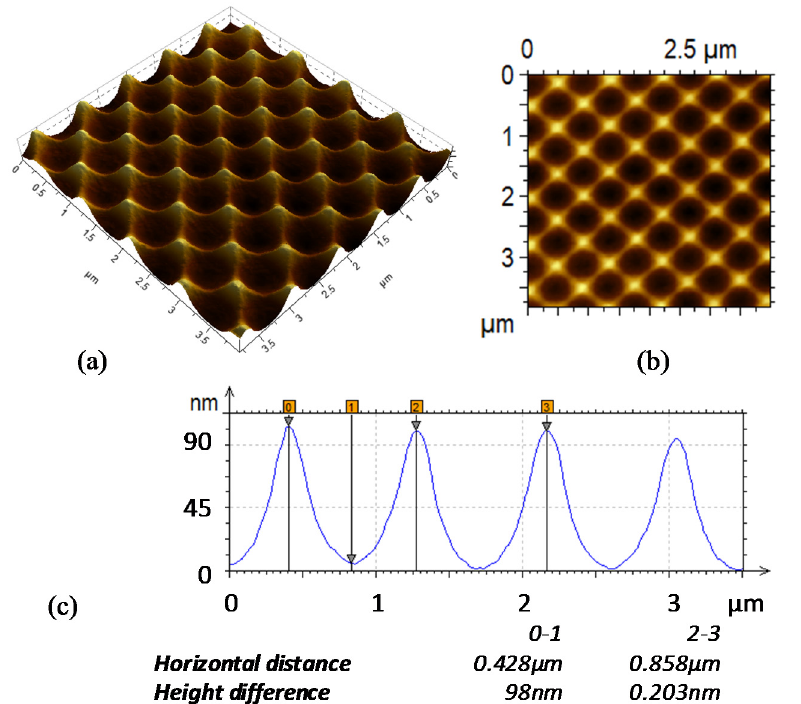
Figure 3. Atomic force microscopy topography of the textured glass superstrate: ( a ) 3D topographic image; ( b ) 2D topographic image; ( c ) cross-section profile in the diagonal direction with respect to the